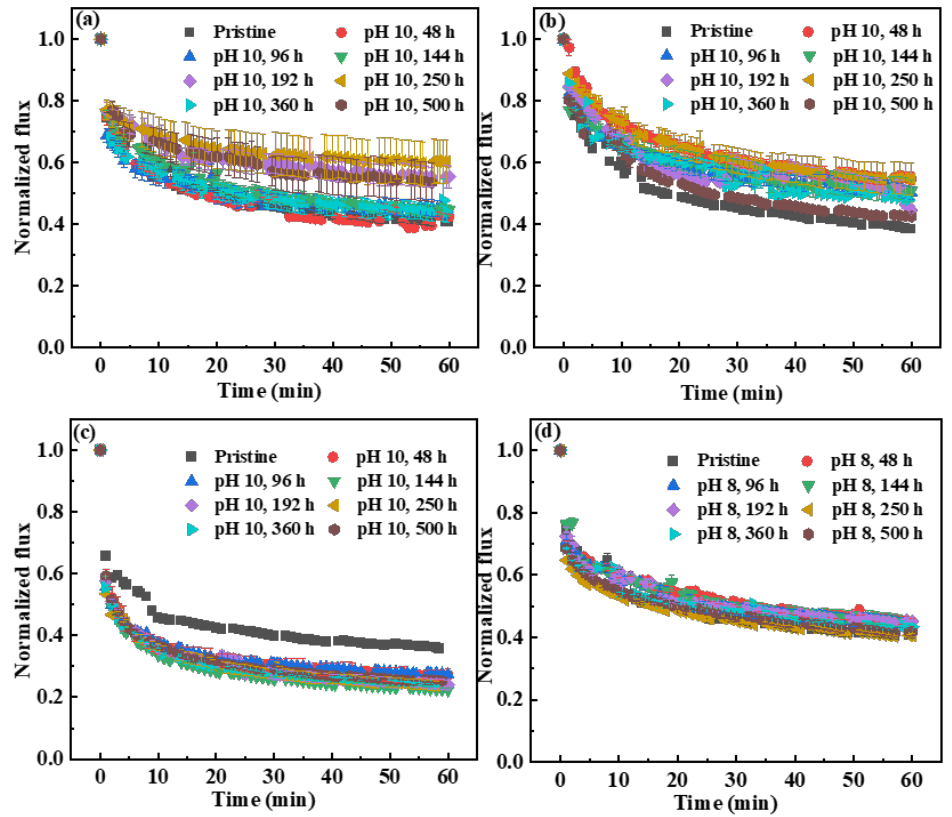
Figure 6. The fouling behaviors of the pristine and NaOCl-exposed membranes. ( a ) A membrane, NaOCl pH 10; ( b ) B membrane, NaOCl pH 10; ( c ) C membrane, NaOCl pH 10; and ( d ) A membrane, NaOCl pH 8.